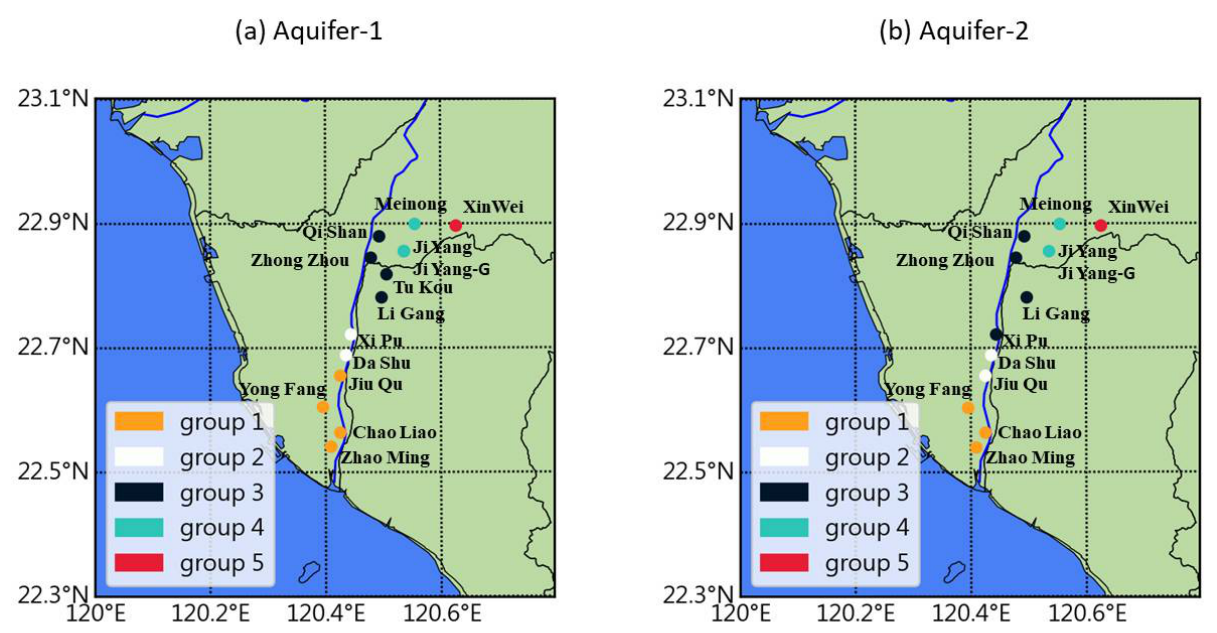
Figure 7. The spatial distribution of hierarchical clustering analysis.